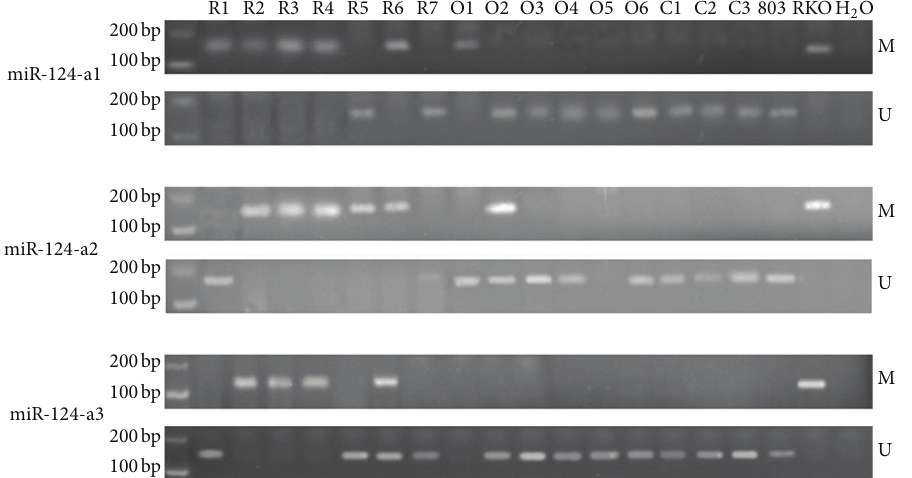
Figure 1: Gel electrophoresis of the MSP products for miR-124-a1, miR-124-a2, and miR-124-a3 in RA, OA patients, and healthy controls. R: rheumatoid arthritis; O: osteoarthritis; C: healthy control; 803 is unmethylated positive control; RKO is methylated positive control; H 2 O is blank control.